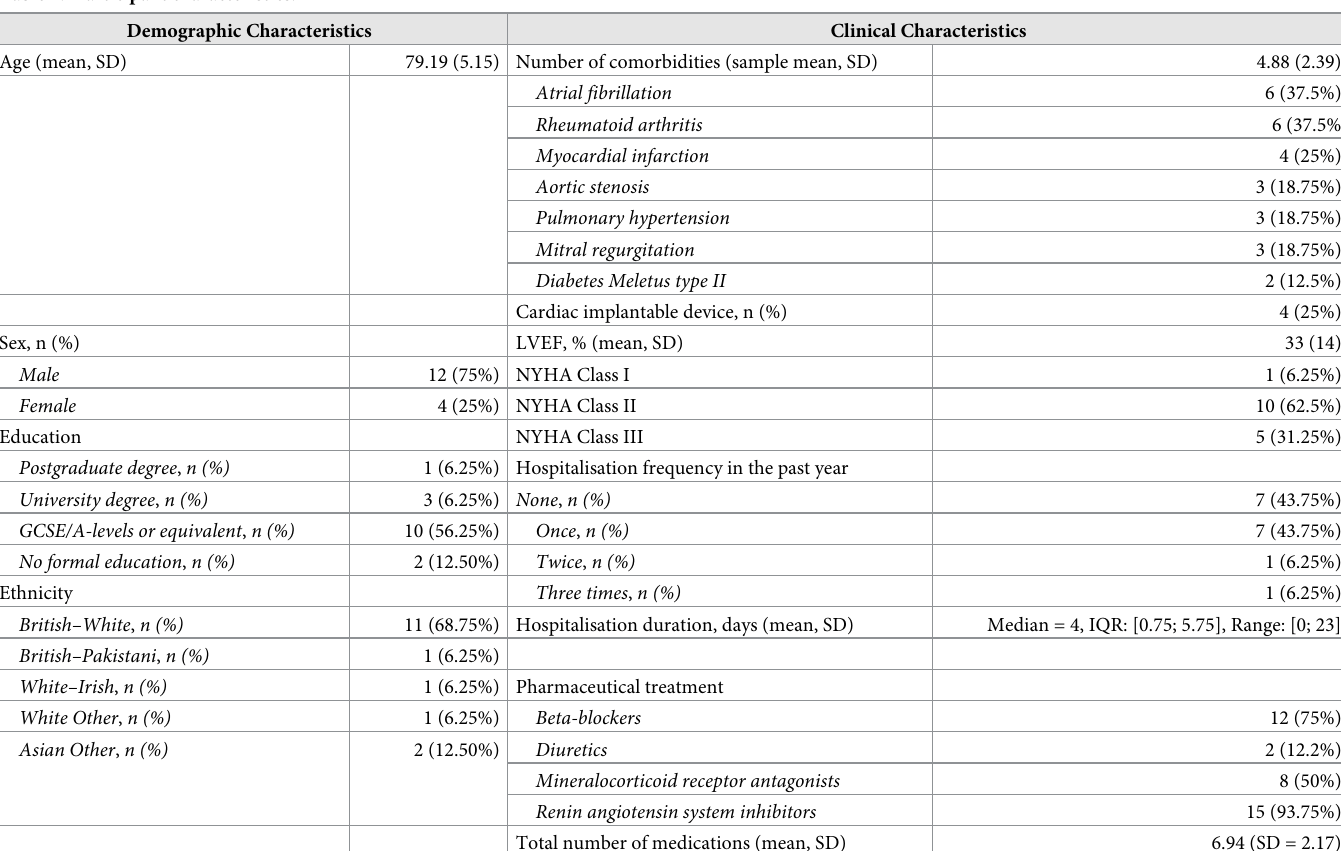
Table 1. Participant